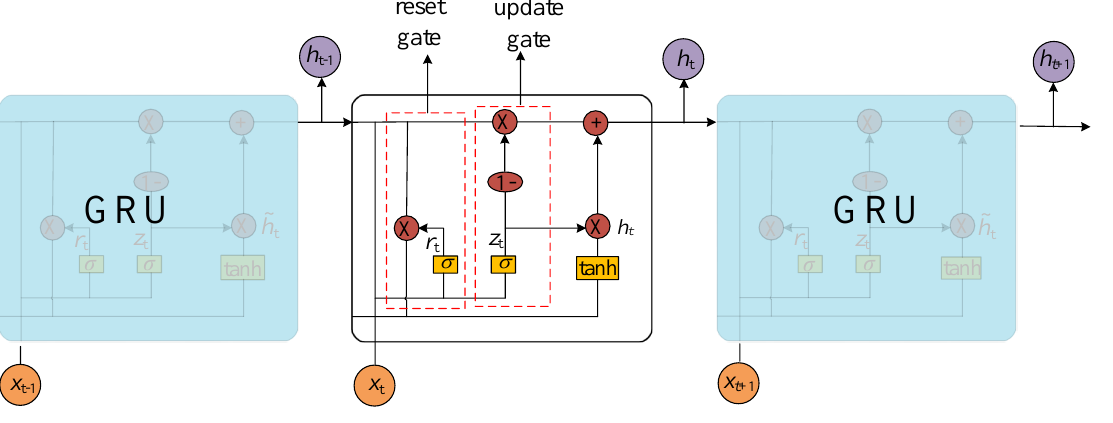
Figure 1. Structure of the GRU.